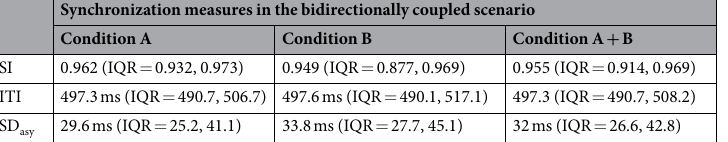
Table 1. Overview of synchronization measure in the bidirectionally coupled scenario. Values are reported as median and interquartile range, due to non-normal distribution of